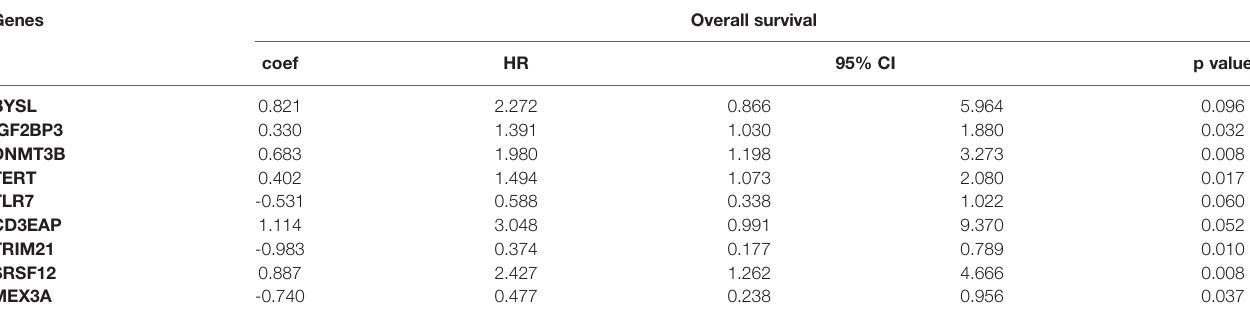
TABLE 1 | Nine prognosis-associated hub RBPs identi fi ed by multivariate Cox regression analysis. Genes Overall survival coef HR 95% CI p value